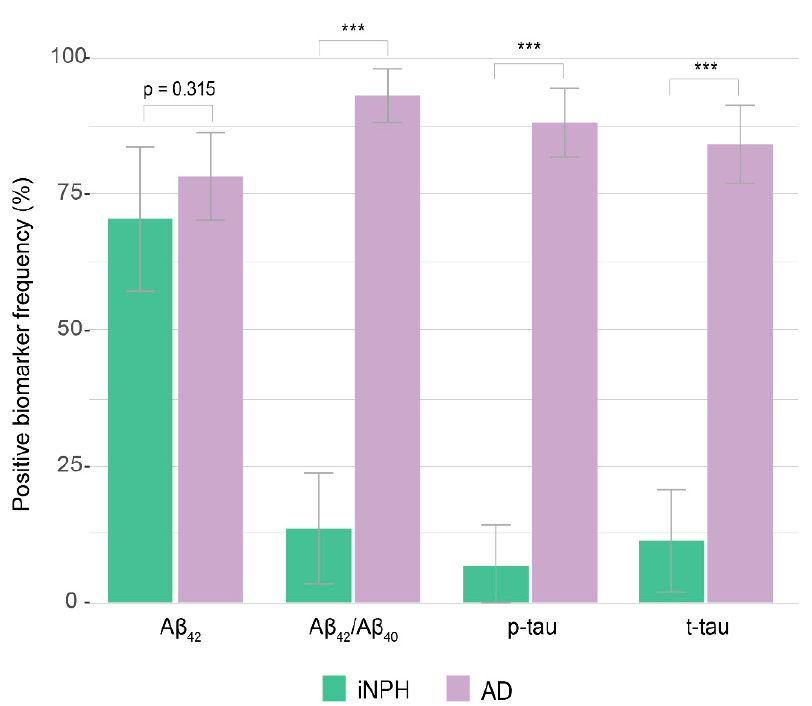
Figure 3. Relative frequencies of positive A β 42 , A β 42 /A β 40 , p-tau, and t-tau in iNPH and AD. Statistical significance received a Bonferroni adjustment and was accepted at p < 0.003. *** p < 0.001.